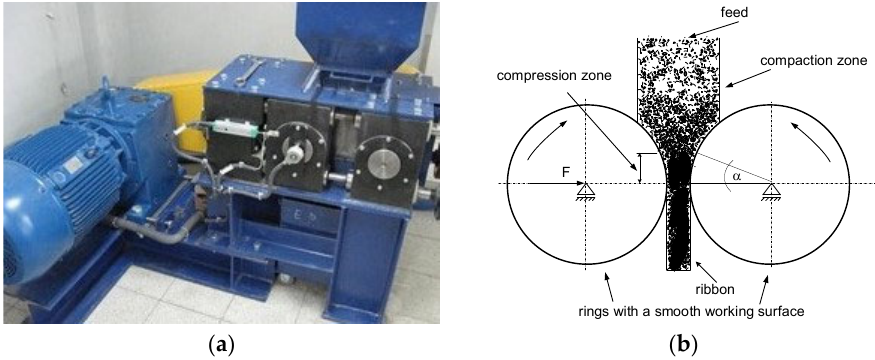
Figure 1. Laboratory ‐ scale high pressure grinding roll HPGR ( a ) and press layout ( b ).